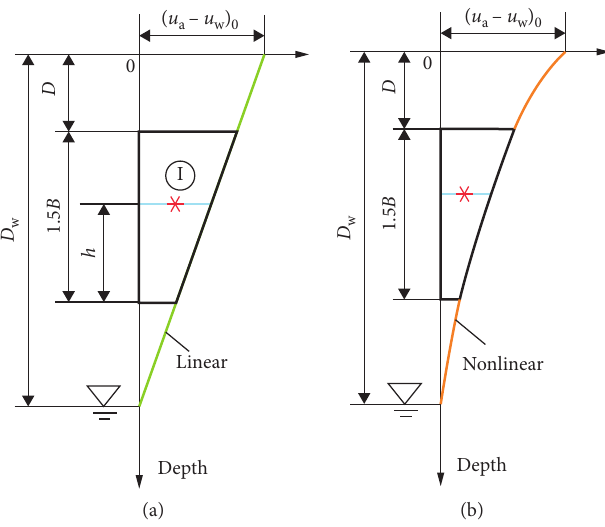
Figure 5: Average matric suction under the nonuniform suction profiles. (a) Linear suction. (b) Nonlinear